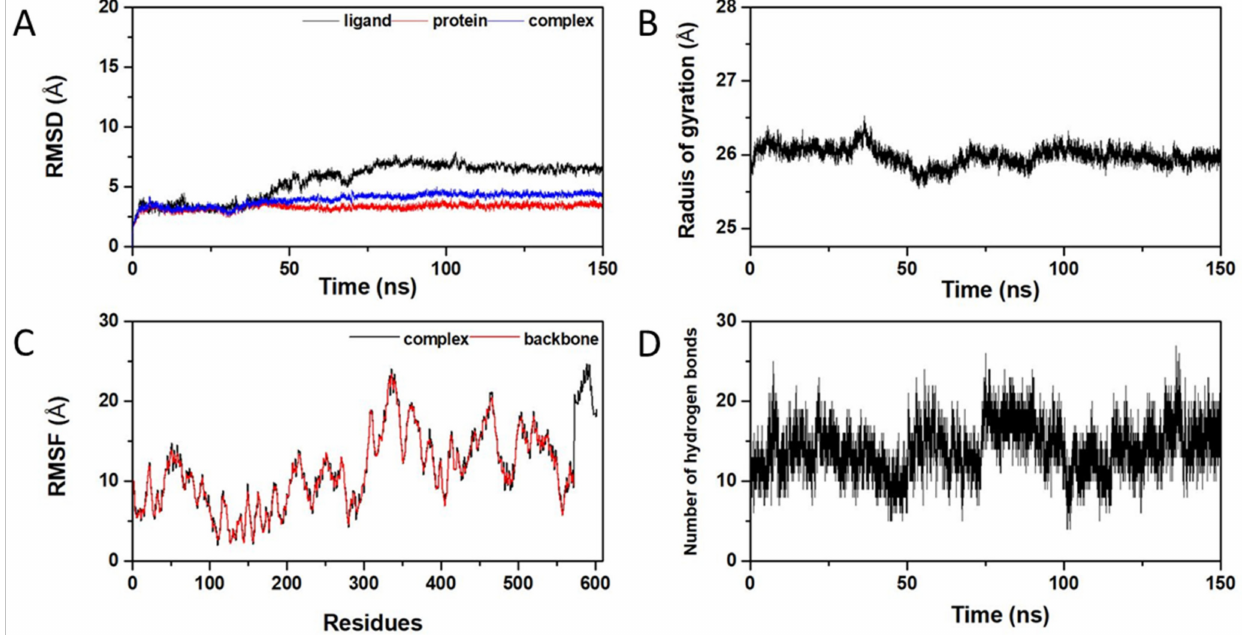
Figure 6. Molecular dynamic simulation of coronavirus 3CLpro–csAVP4 complex: ( A ) RMSD profiles of the csAVP4 ligand (black) 3CLpro protein backbone (red) and RMSD profiles of 3CLpro–csAVP4 complex (blue); radius of gyrus plot of the 3CLpro–csAVP4 complex ( B ); RMSF profile of the 3CLpro– csAVP4 complex ( C ); and hydrogen bonds plot for the 3CLpro–csAVP4 complex ( D